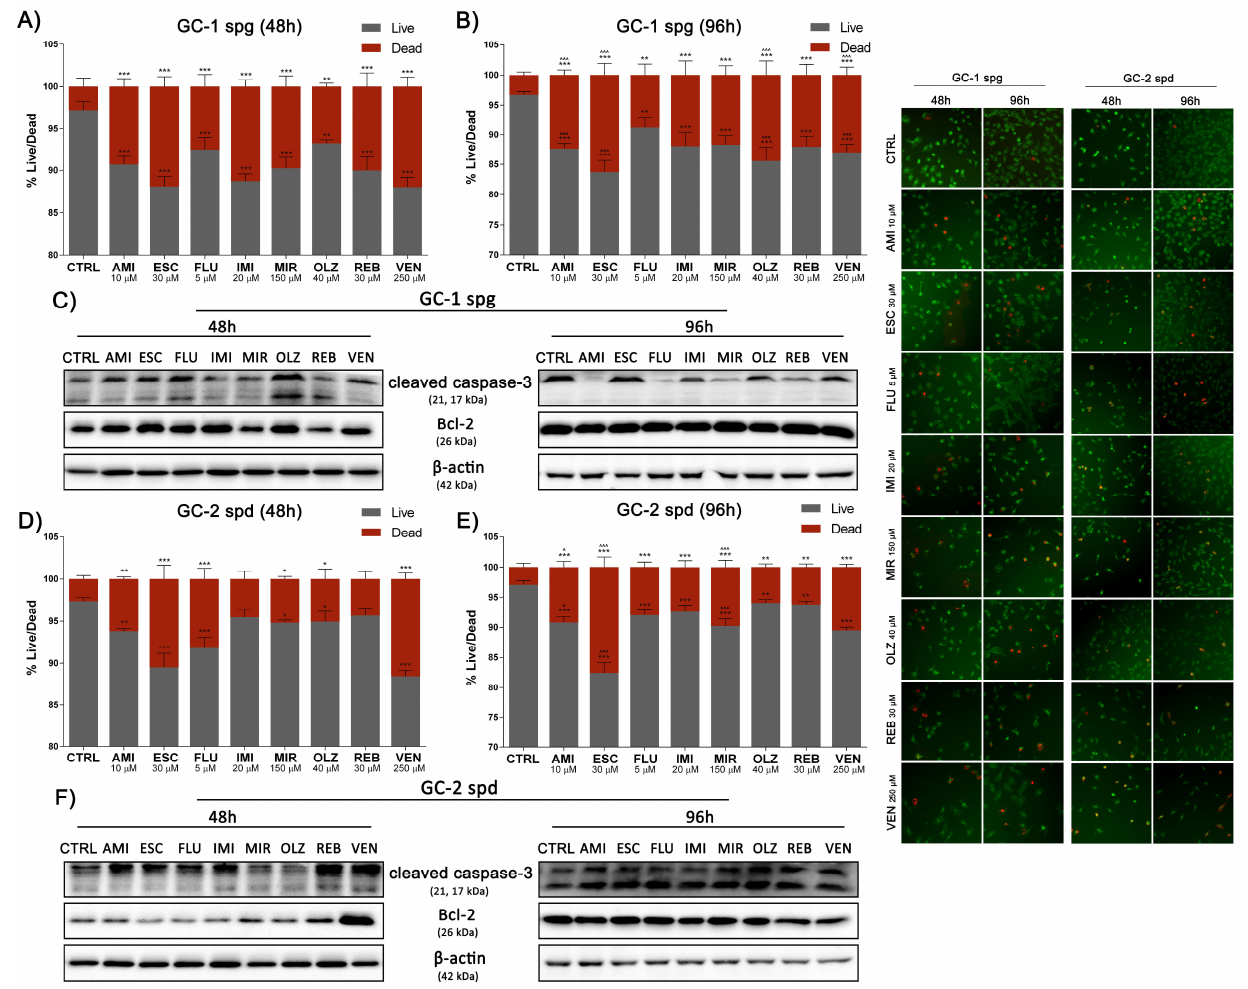
Figure 7. Antidepressants reduce cell viability and induce apoptosis. Mouse GC-1 spg and GC-2 spd cells were treated with antidepressants for 48 and 96 h, subjected to simultaneous fluorescence staining of viable and dead cells ( A , B , D , E ) and then the level of cleaved caspase-3, Bcl-2 was controlled by Western blot technique. Representative blots ( C , F ) and photos of Calcein/PI staining are shown (magnification 10×). Green fluorescence (FITC) live cells, red fluorescence (Texas